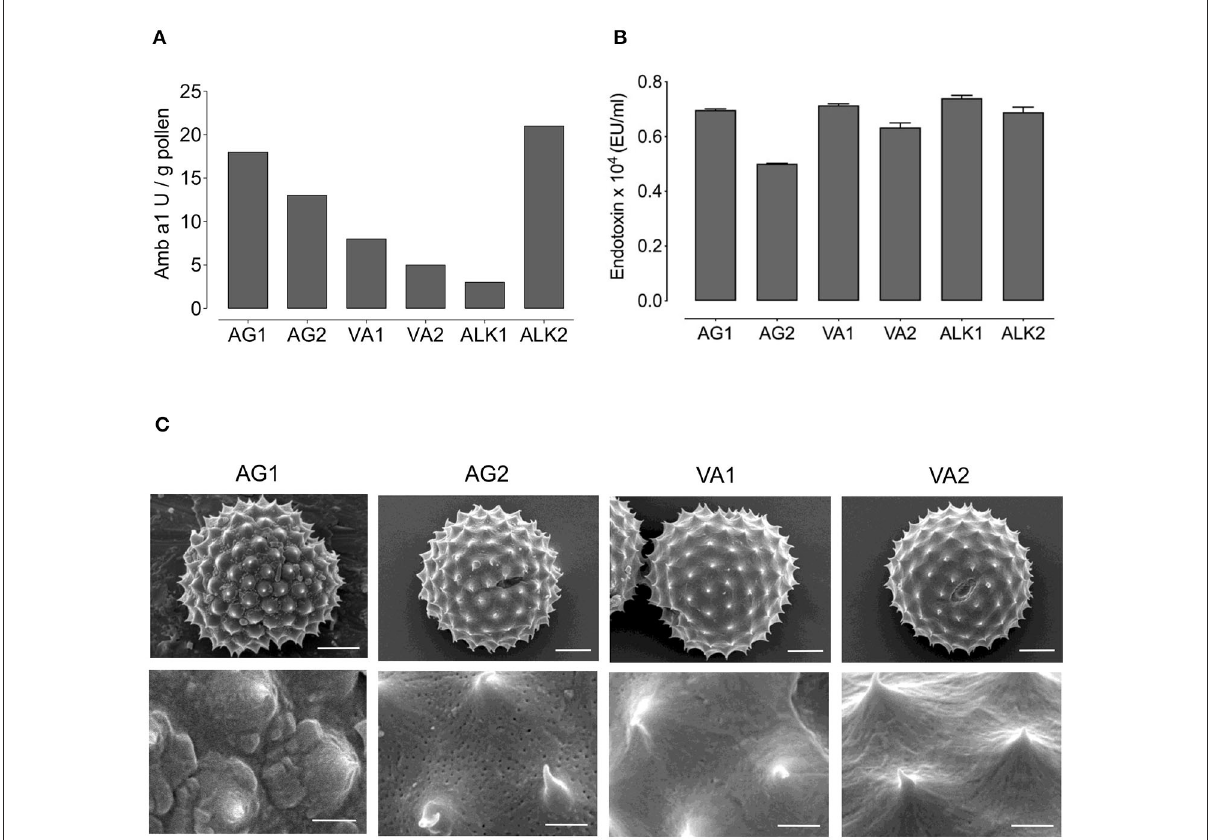
FIGURE1 Amb a 1 and endotoxin content, and structure of RWP from different geographical locations. The concentrations of (A) Amb a 1 in Units/gram (U/g) and (B) Endotoxin in EU/ml in tested RWP samples. (C) Scanning electron microscopy photomicrographs were taken of AG1, AG2, VA1, VA2 pollen to examine the structure at magnification of 5,000 × in top row (scale bars = 5 µ m) and 21,600 × at bottom row (scale bars = 1 µ